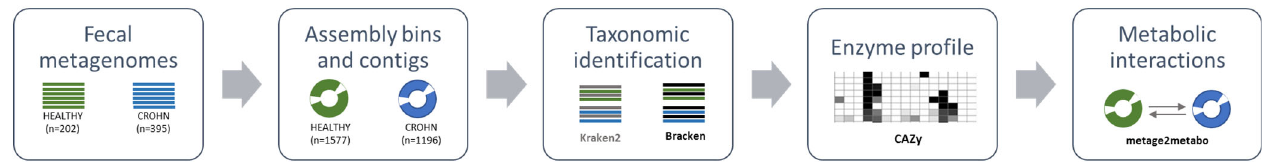
Figure 1. Computational workflow used in this work. Metagenome-assembled genomes (MAGs) were recovered from the microbiota of patients with Crohn’s disease and healthy individuals. Taxonomic identification of MAGs was performed using Kraken2 and Bracken software. MAGs sequences were mapped against the Carbohydrate-Active enZYmes Database (CAZy) to annotate glycosidase domains. Finally, metabolic interactions between MAGs were elucidated using metage2metabo software (v. 1.5.0) developed by Belcour et al. [8]. Table 1. Number of metagenome-assembled genomes (MAGs, n = 998) recovered from the microbiota of patients with Crohn’s disease and assigned to taxonomic clades that were also found in the microbiota of healthy individuals. MAGs were identified at family, genus, species or strain level. It should be noted that these common clades (total number of different taxa n = 41) were identical to those shown in Table 2.